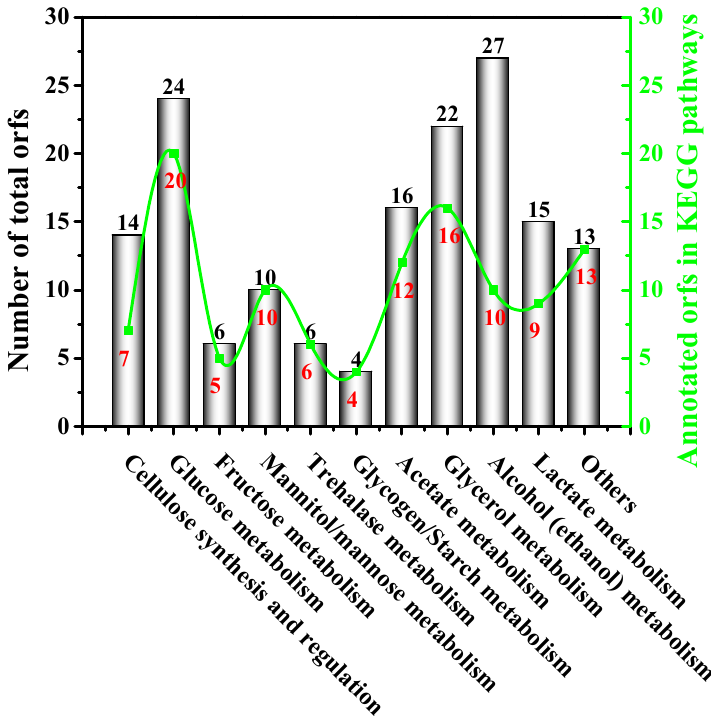
Figure 5. The number of orfs associated with carbon source metabolisms and BC biosynthesis and regulation. The orfs shown here were retrieved from the genes and corresponding protein annotation data. While the numbers on the top of the bars indicate the total number of predicted genes involved in carbon source metabolisms and BC biosynthesis and regulation, the ones below the line indicate the number of the genes that can be annotated to certain Kyoto Encyclopedia of Genes and Genomes (KEGG) pathways. It’s worthy to note that the description ‘others’ indicates the key metabolic intermediates during the transformation between glucose and glycerol or fructose and glycerol. More details can be found in Tables S1 and S2.